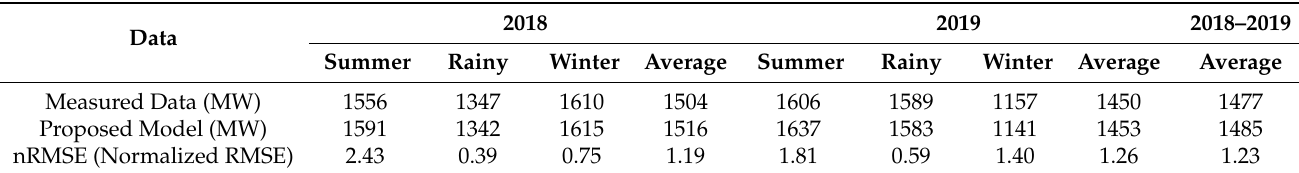
Table 8. Comparison of the results of the proposed model and the measured data in 2018–2019.